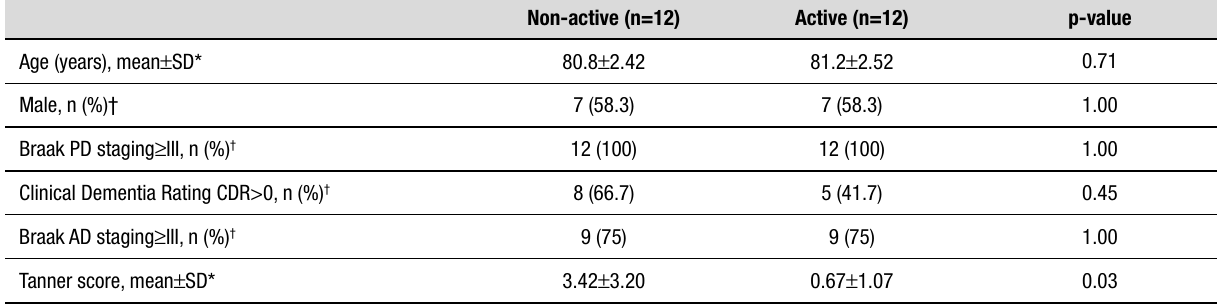
Table 1. Characteristics of the sample (n=24).